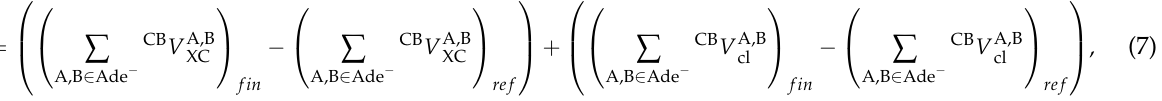
Table 2. CCSD-computed changes in the total intramolecular interaction energy of the adeninate anion − ( ∆ E Ade ), the total CB-interactions ( ∆ CB E Ade int the indicated Na-Ade and K-Ade complexes. All values in kcal mol − 1